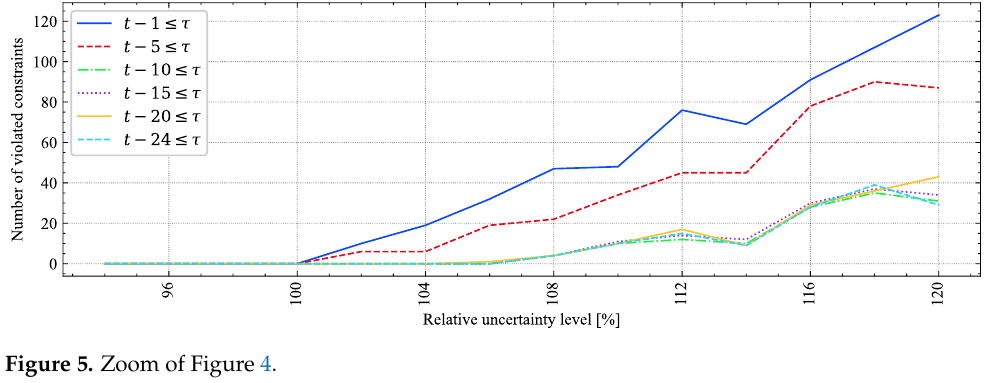
Figure 5. Zoom of Figure